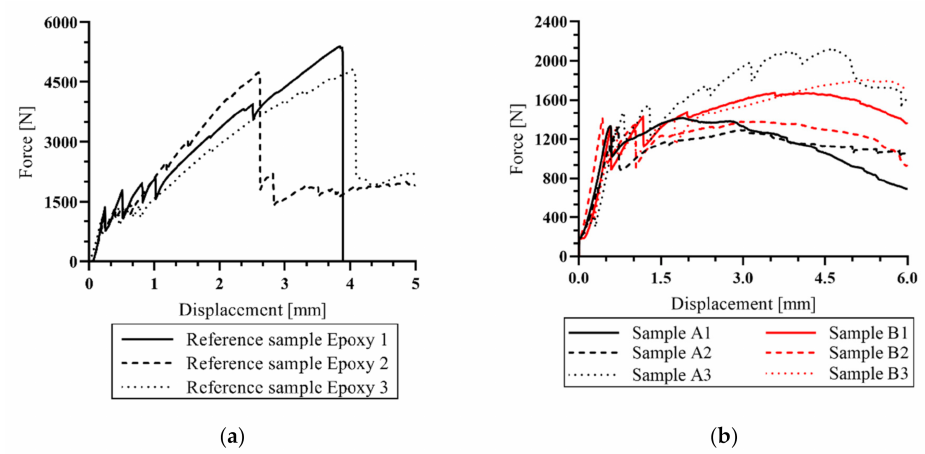
Figure 13. Measured data from four-point bending test: ( a ) Reference samples; ( b ) Comparison of sample series A and B.